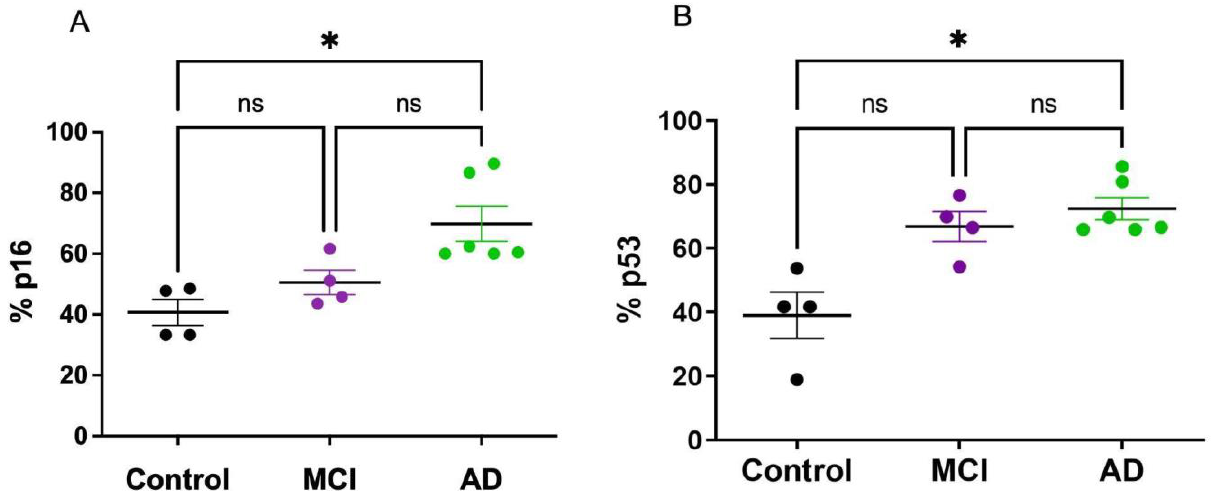
Figure 3. p16 and p53 expression was increased in PBMCs of AD patients. The expression of p16 ( A ) and p53 ( B ) was determined by flow cytometry in PBMCs from controls (n = 4), aMCI (n = 4) and AD (n = 6) patients. p16 and p53 expression was increased in AD patients compared with healthy controls, with no significant change in aMCI. Statistical analysis: Kruskal – Wallis with Dunn’s post hoc correction * p < 0.05, ns = non-significant.